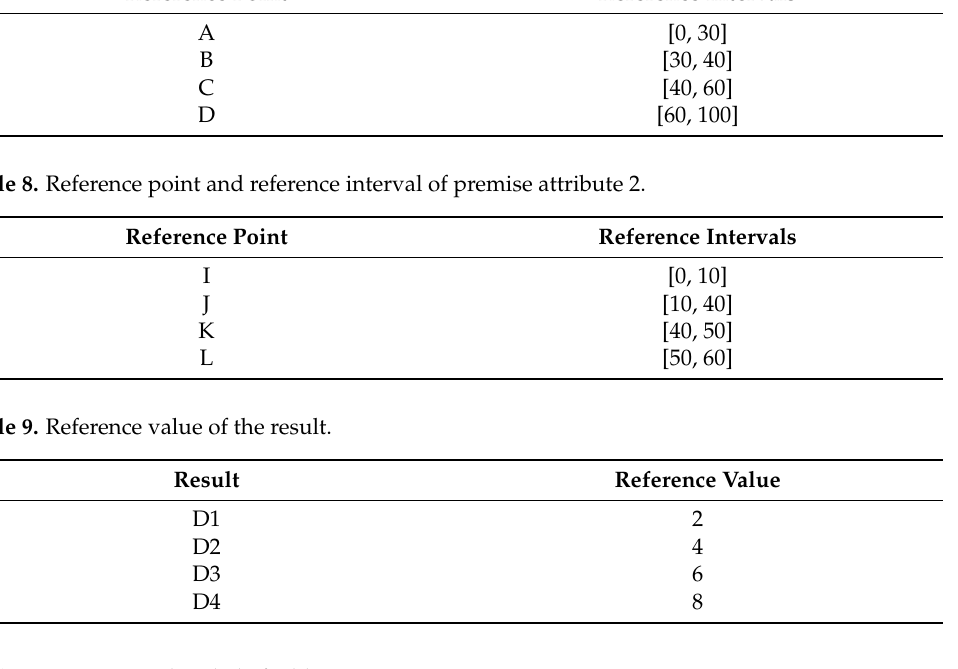
Table 10. Corresponding belief